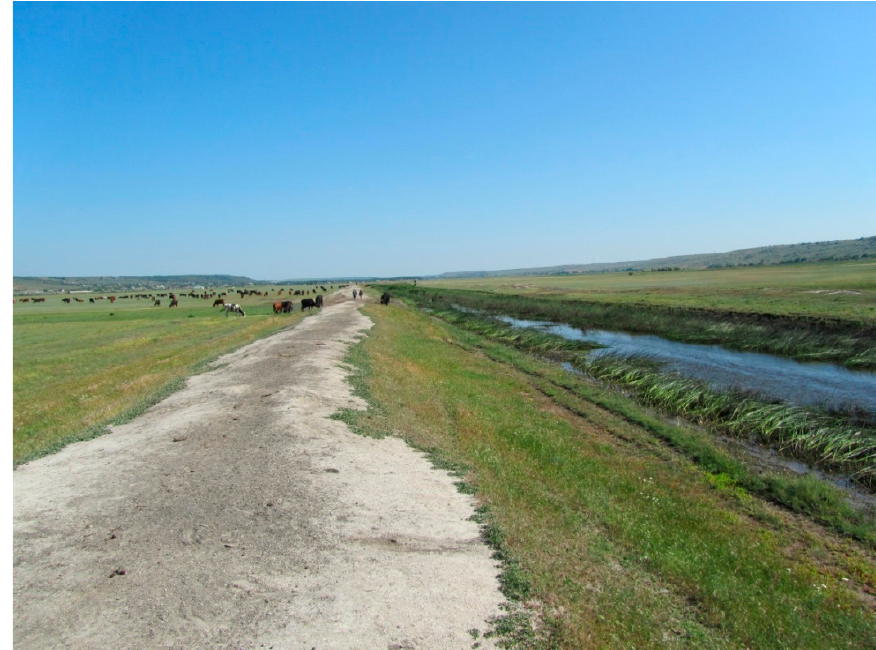
Figure 8. The Dam of the canalized riverbed of Great Kuyalnik River (surroundings of Severynivka village).